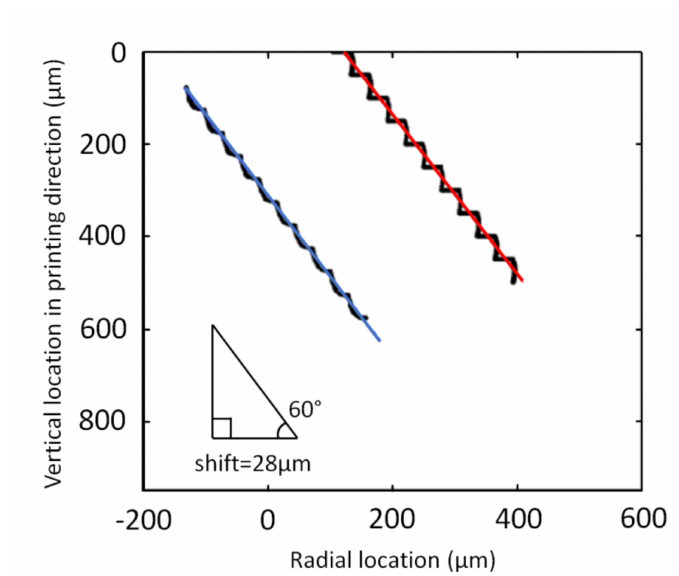
Figure 11. 60 ◦ angled strut and its mean profiles for upper (red) and lower (blue) surface profile. Table 8. Objectives comparison between optimized and non-optimized printing